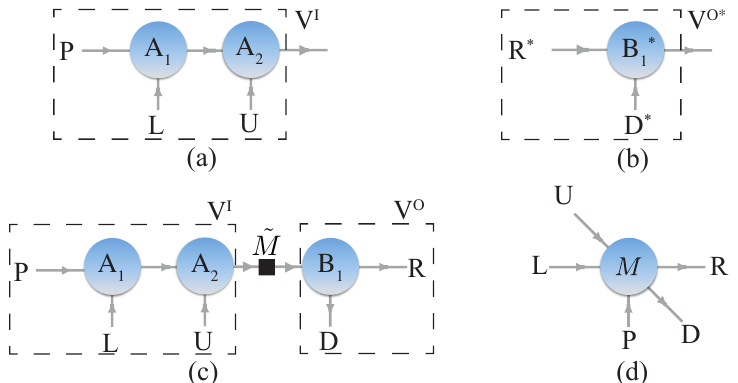
Figure 12: Steps (a)-(c) for building rank-5 PEPS tensor in (d) from ele- mentary rank-3